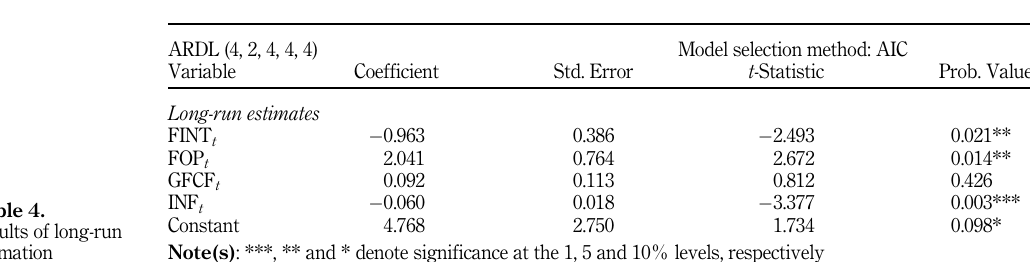
Table 3. Bounds test for cointegration relationship